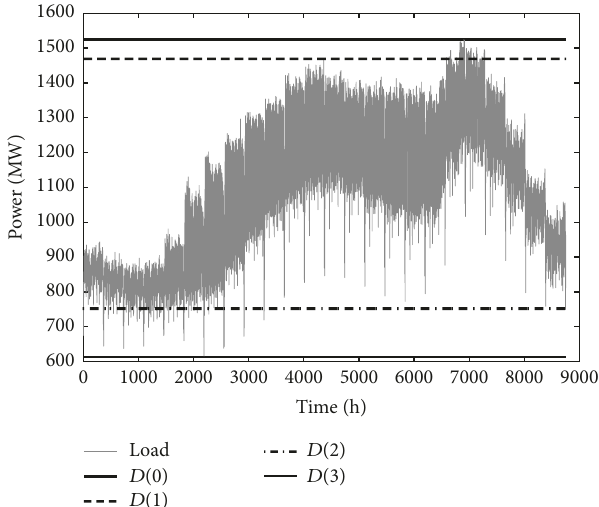
Figure 3: Matched block derivatives. Table 1: Δ𝑝 𝑗 values for each